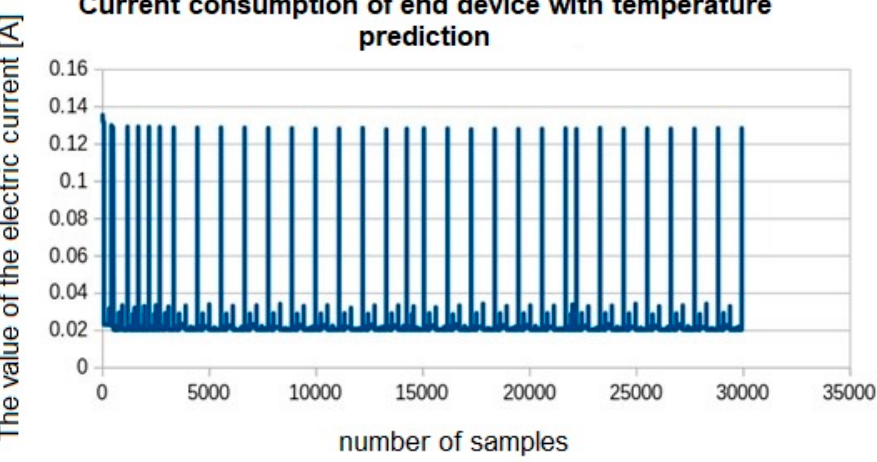
Figure 8. Graph of electricity consumption of the end device without the use of optimization methods.